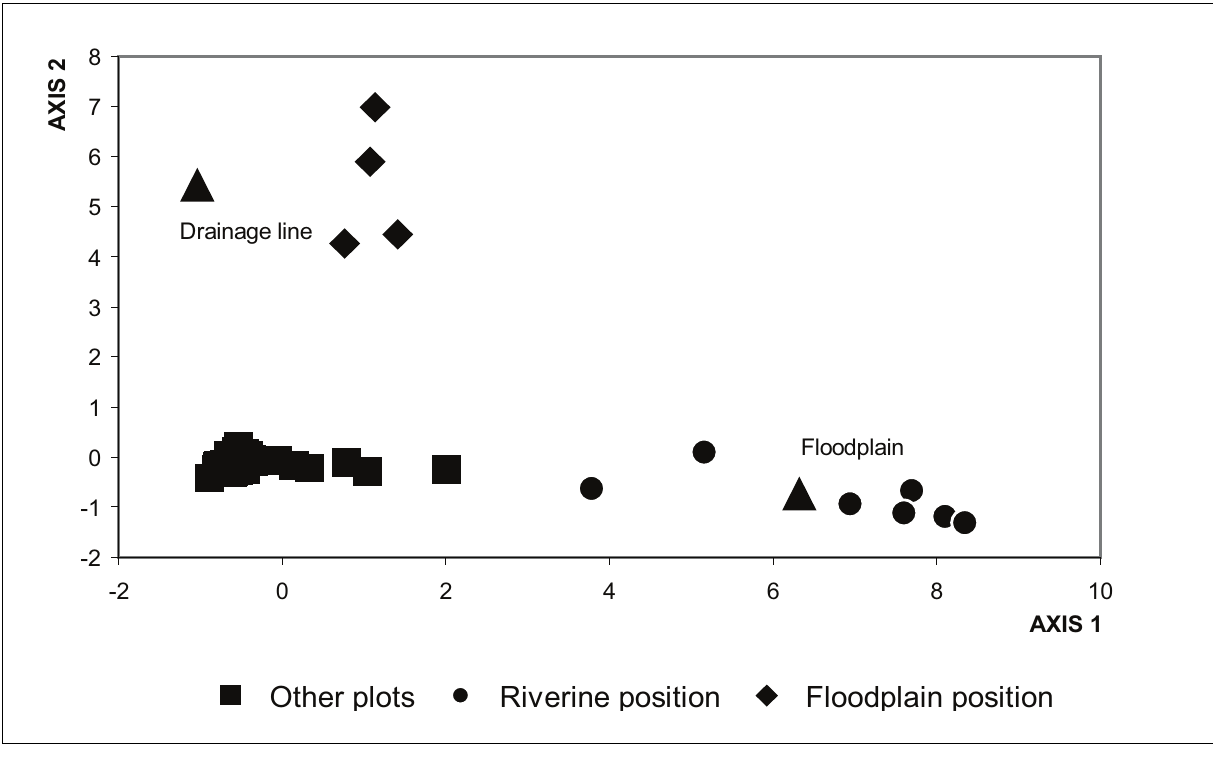
FIGURE 3 CCA ordination biplot of 75 vegetation sample plots in the Parque Nacional de Zinave using nominal environmental variables, where triangle symbols represent the centroids of the environmental variables ‘floodplain’ and ‘drainage line’